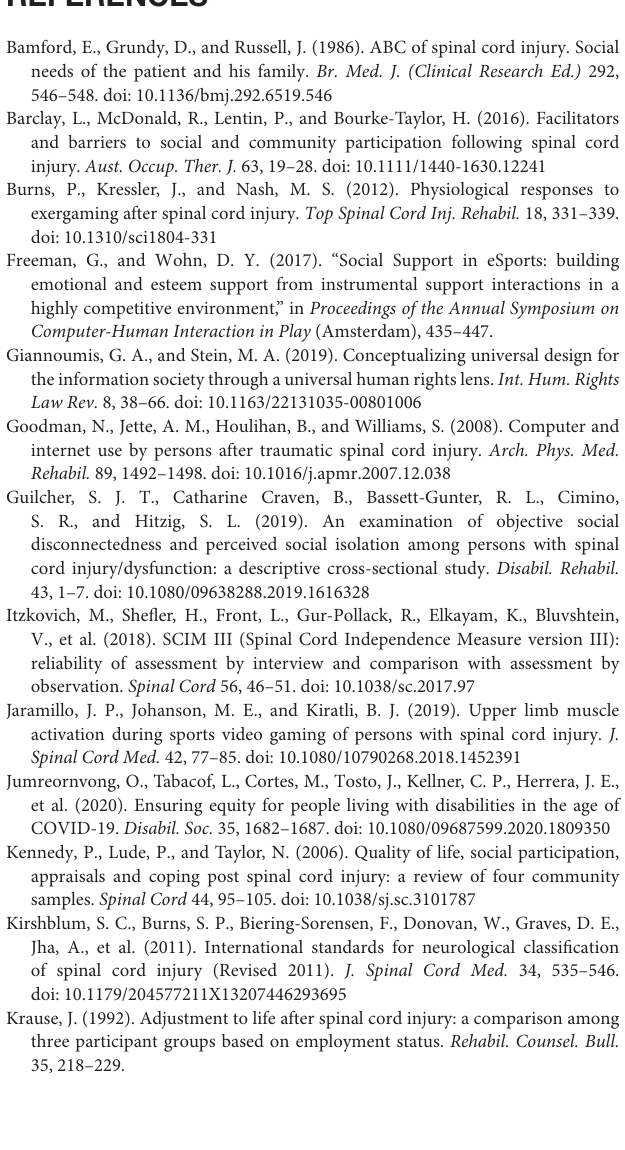
Supplementary Figure 1 | A sample of the button mapping created for users of the QuadStick to play a shooting game on an Xbox. Column A holds the button